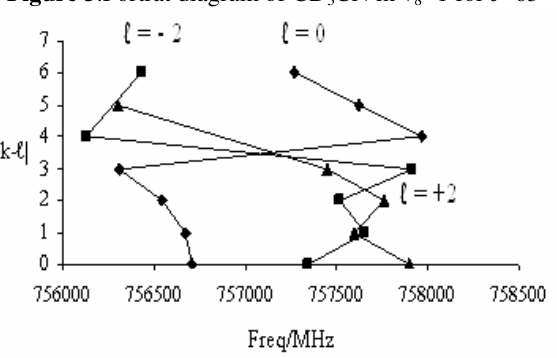
Figure 4 . Fortrat diagram of CD